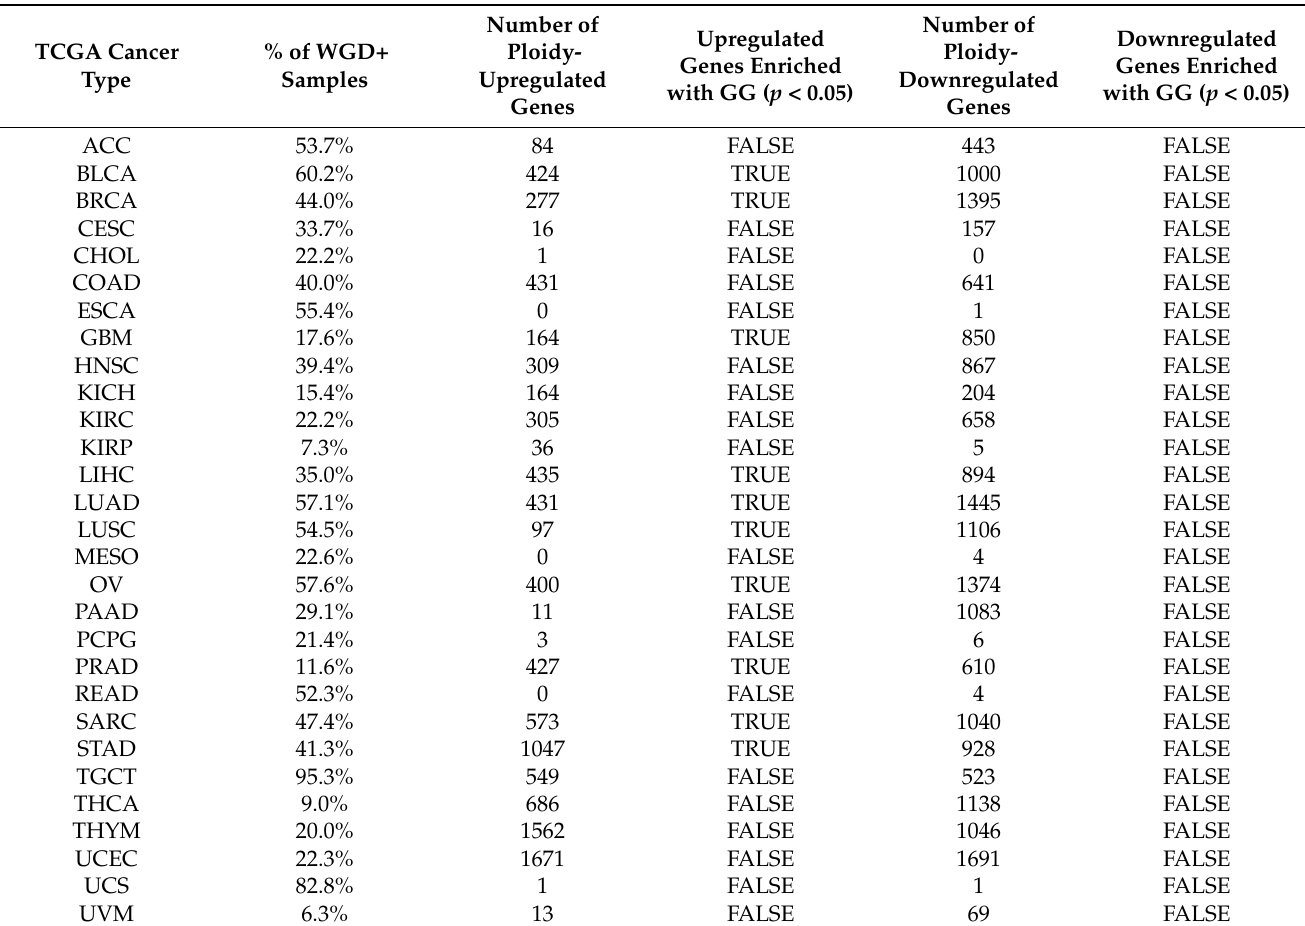
Table 1. The prevalence of GG genes found among ploidy-upregulated and downregulated differen- tially expressed genes (DEGs)